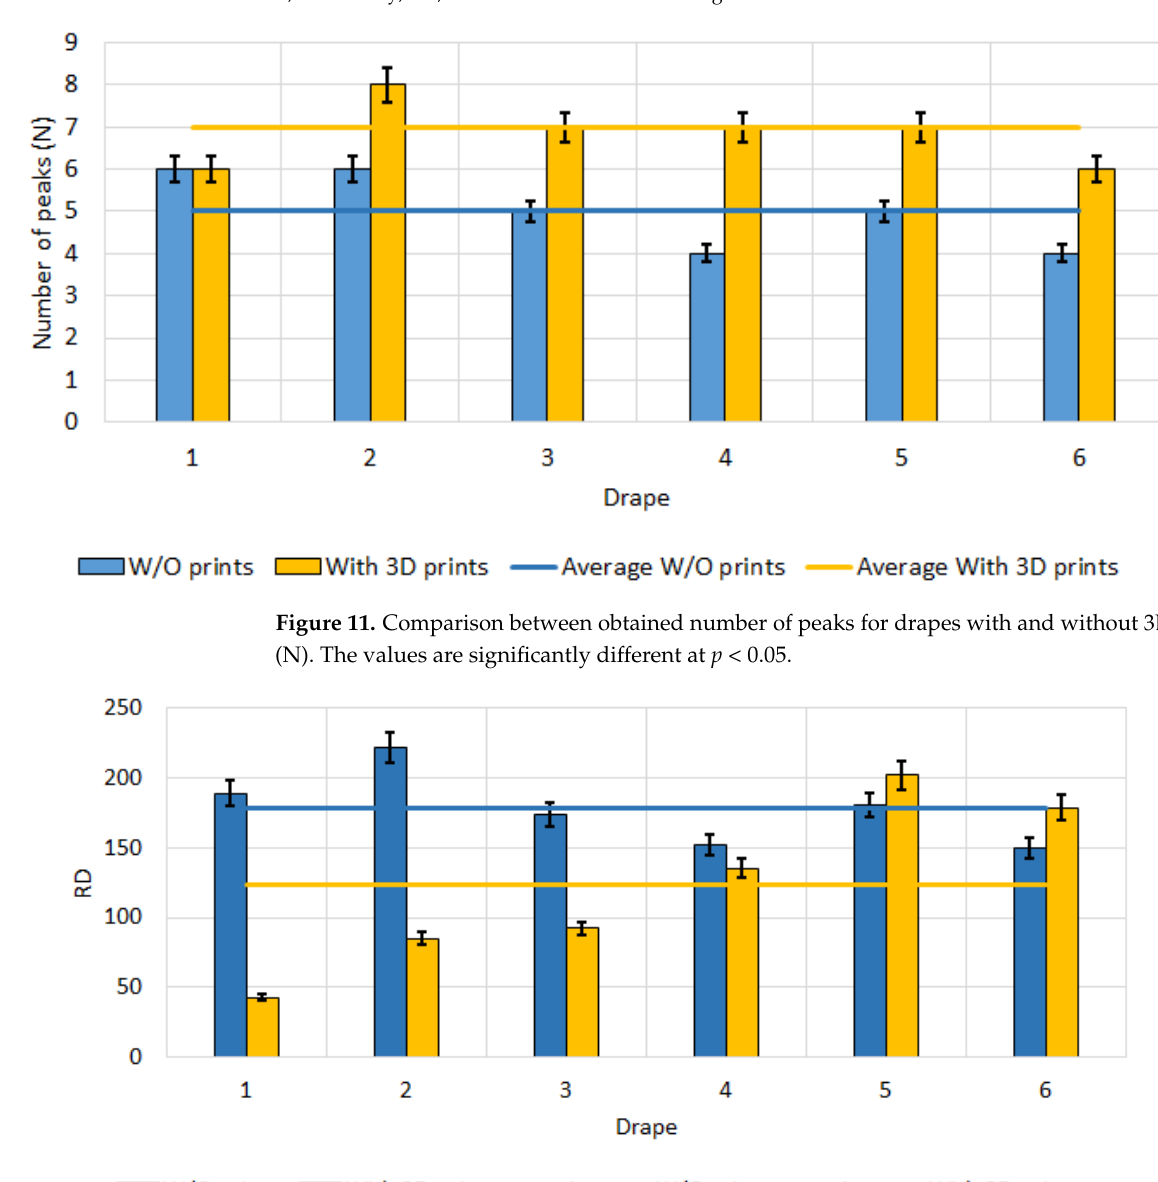
Figure 12. Changes in RD. The values are significantly different at p < 0.05.